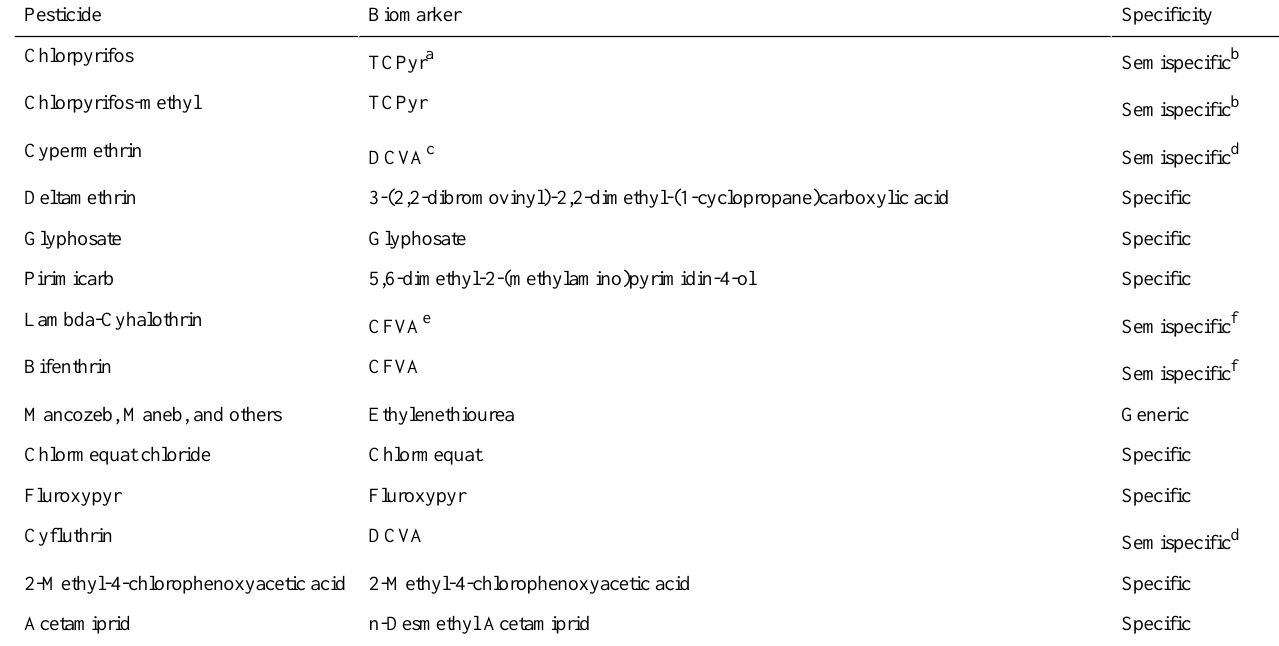
Table 2. List of active ingredients to be prioritized for exposure assessment by biological monitoring.